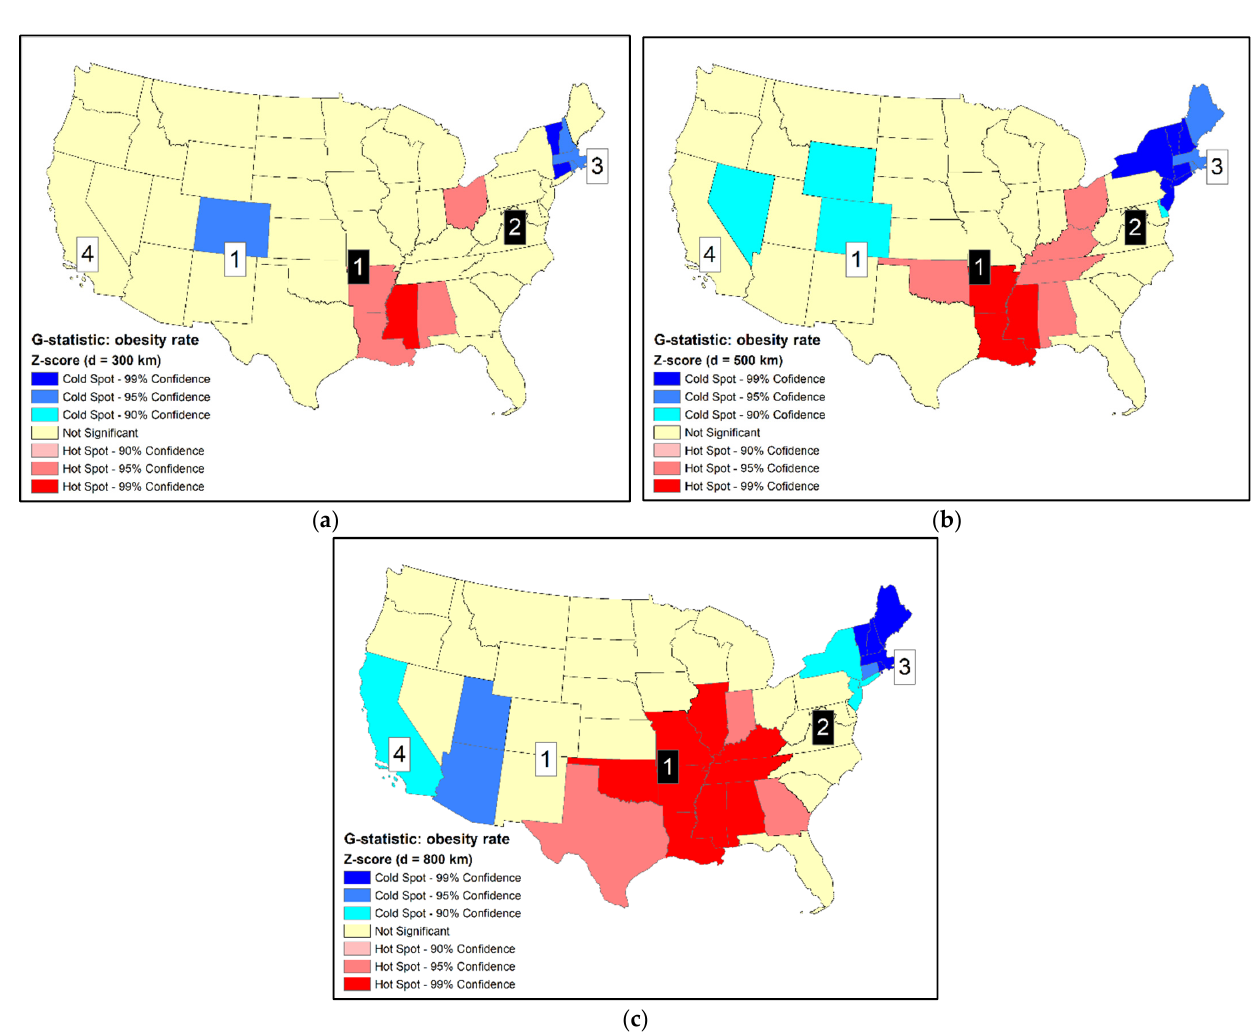
Figure 2. ( a ) Standardized scores of Gi of adult obesity rates by states of the U.S., 2014 (d = 300 km); ( b ) standardized score of Gi (d = 500 km); ( c ) standardized score of Gi (d = 800 km). Selected ranks (1, 2, 3, 4) are identified (black squares: high-value ranks; white squares: low-value ranks).